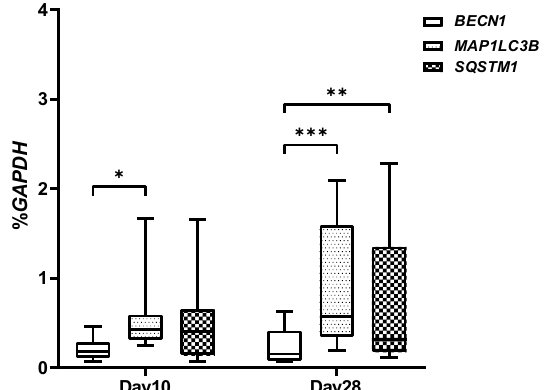
Figure 6. Real-time PCR analysis of the BECN1 , MAP1LC3B , and SQSTM1 genes on chondrogenic differentiated hASCs embedded in VG-RGD hydrogel, at days 10 and 28. Data were expressed as % GAPDH (housekeeping gene) and represented as a boxplot with median, minimum, and maximum. Kruskal–Wallis with Dunn’s multiple comparisons test was used for statistical analysis: * indicates differences along time points (day 10 to day 28); * p < 0.05, ** p < 0.005, *** p < 0.0005.